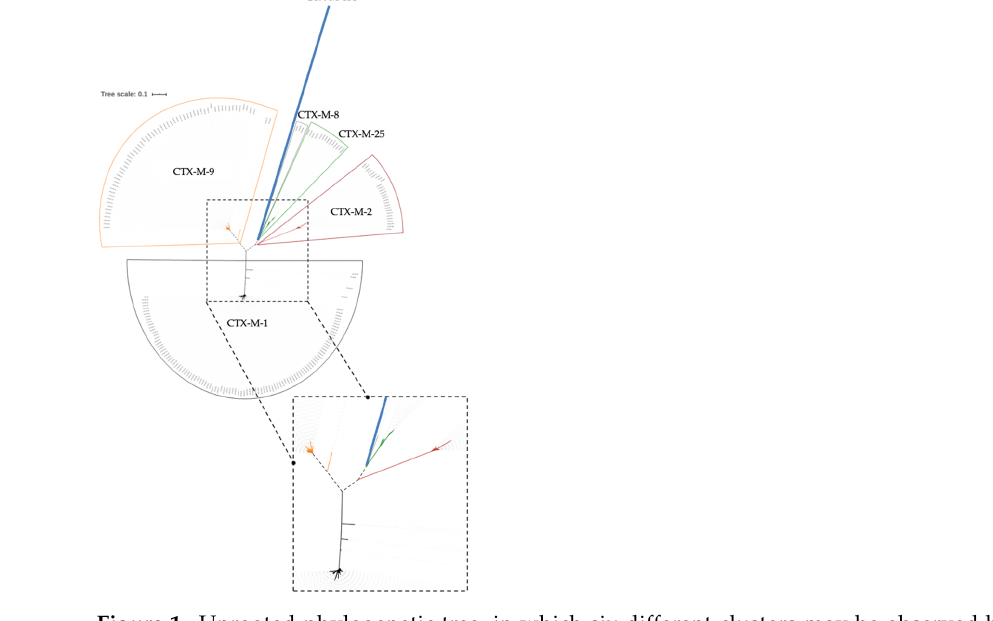
Figure 1. Unrooted phylogenetic tree, in which six different clusters may be observed by colors (in black, the CTX-M-1 cluster; in red, CTX-M-2; in grey, CTX-M-8; in orange, CTX-M-9; in green, CTX-M-25; and in blue, CTX-M-151).